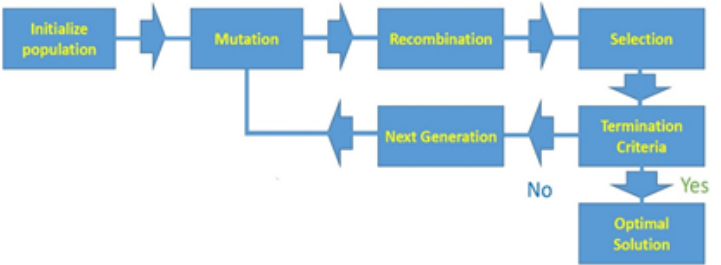
Figure 3. Block diagram of the operating steps of the differential evolution